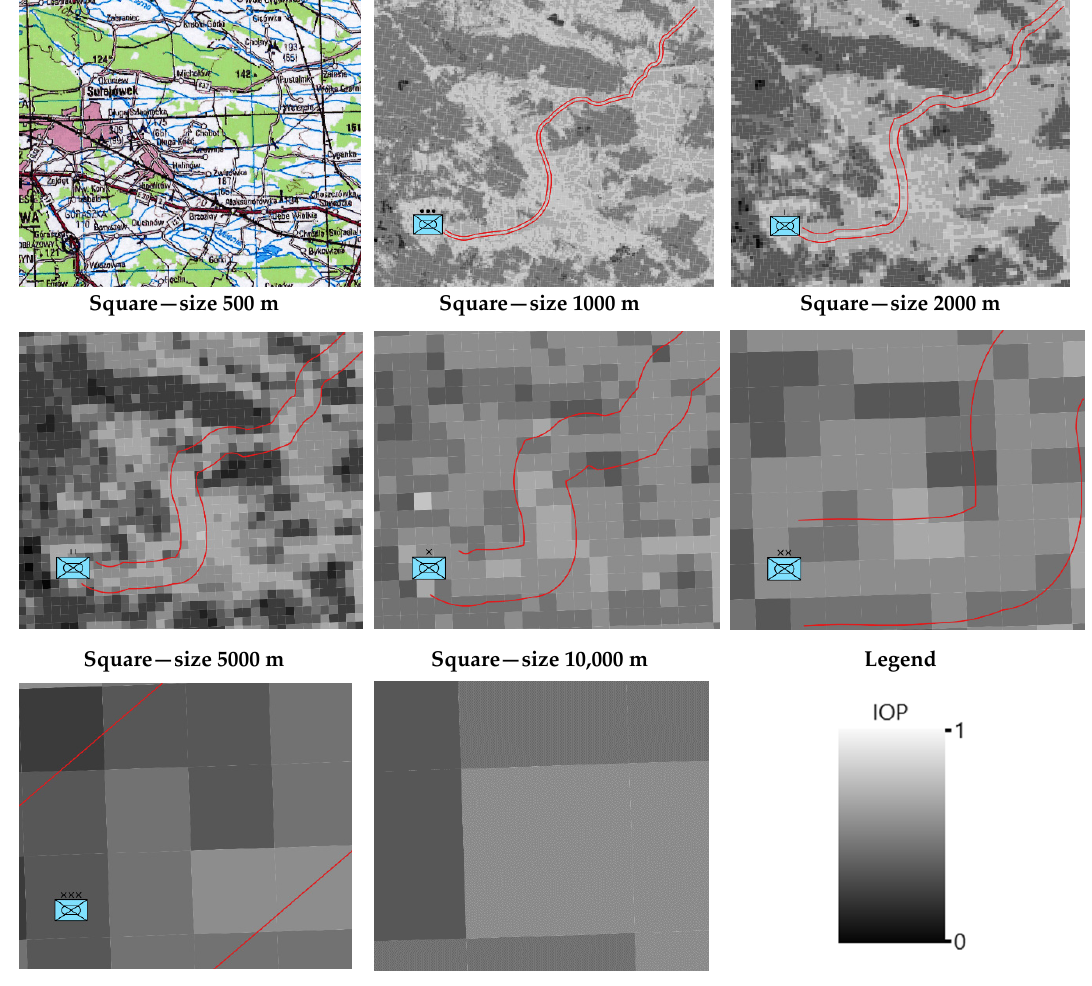
Figure 13. Parts of passability maps for various sizes of cell generated for the area of the Warsaw Agglomeration.